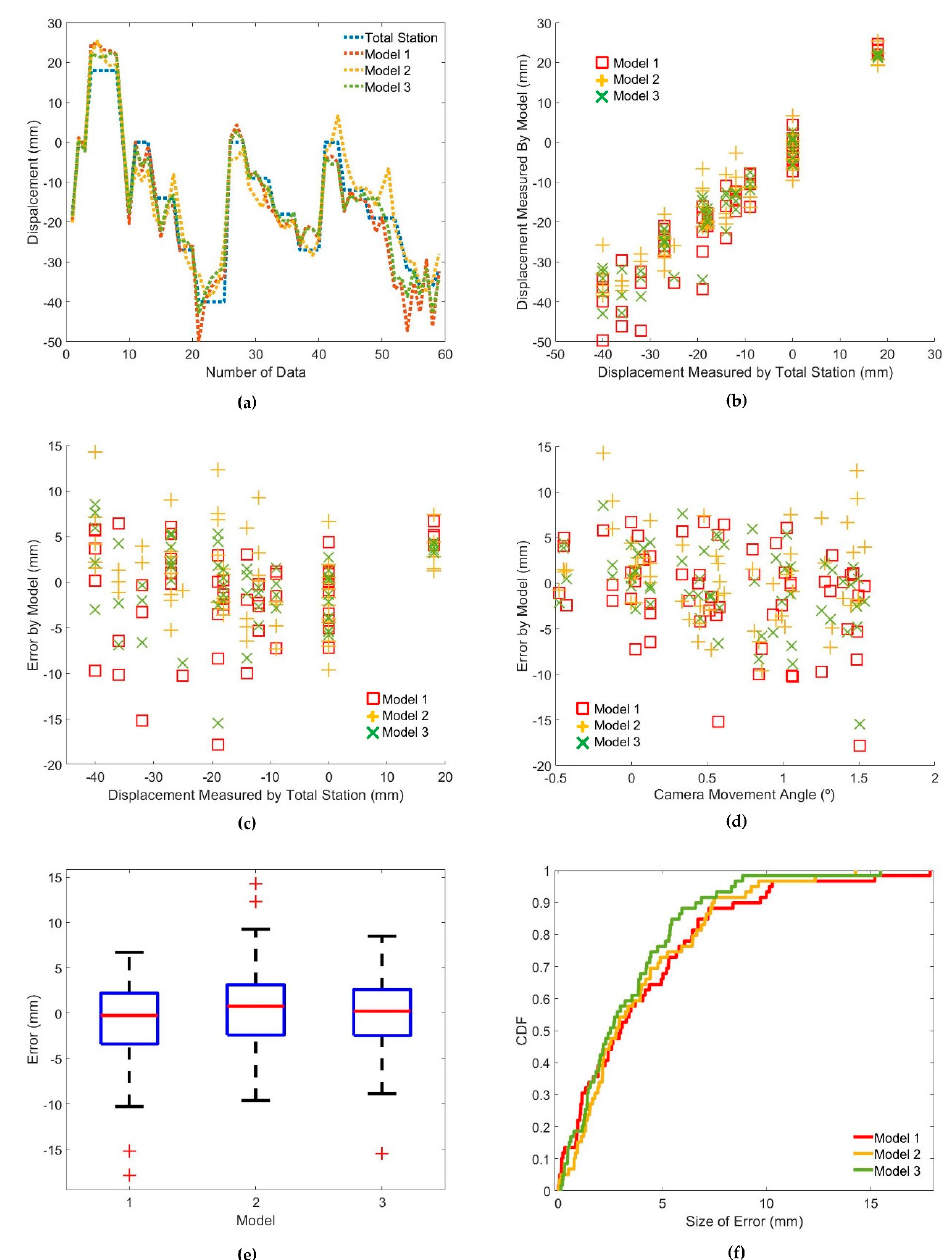
Figure 12. Results of displacement measurement by model: ( a ) measured displacement using total station and the proposed models; ( b ) displacement measured by the models vs. displacement measured by the total station; ( c ) errors of each model vs. displacement measured by the total station; ( d ) errors of each model vs. camera movement angle; ( e ) box plot of error for each model; ( f ) cumulative density function of error size in each